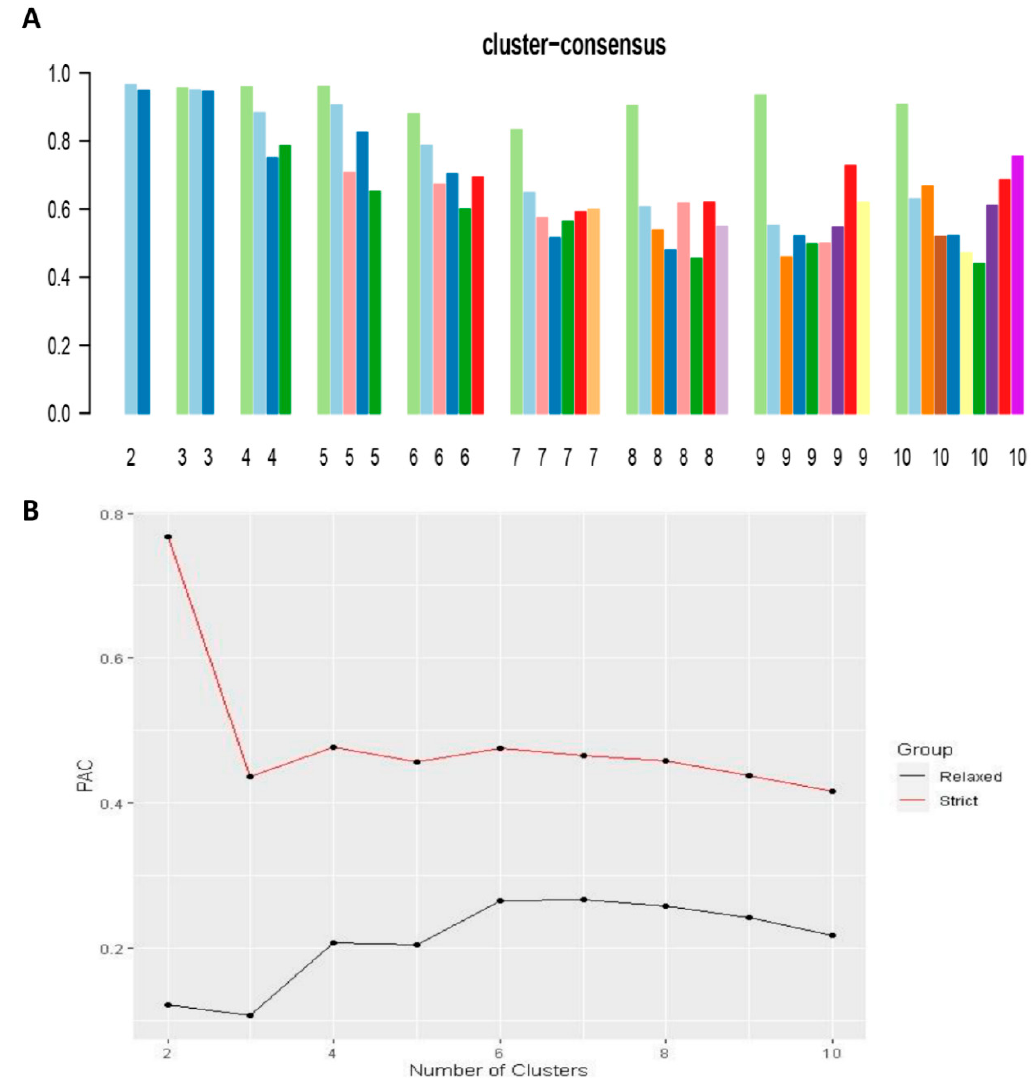
Figure 3. ( A ) The bar plot represents the mean consensus score for different numbers of clusters (K ranges from two to ten) for ICU patients with lactic acidosis; ( B ) The PAC values using the strict criteria (red line) with the predetermined boundary of (0, 1), and the PAC values using the relaxed criteria (black line) with the predetermined boundary of (0.1, 0.9) as the definition for ambiguously clustered pairs.